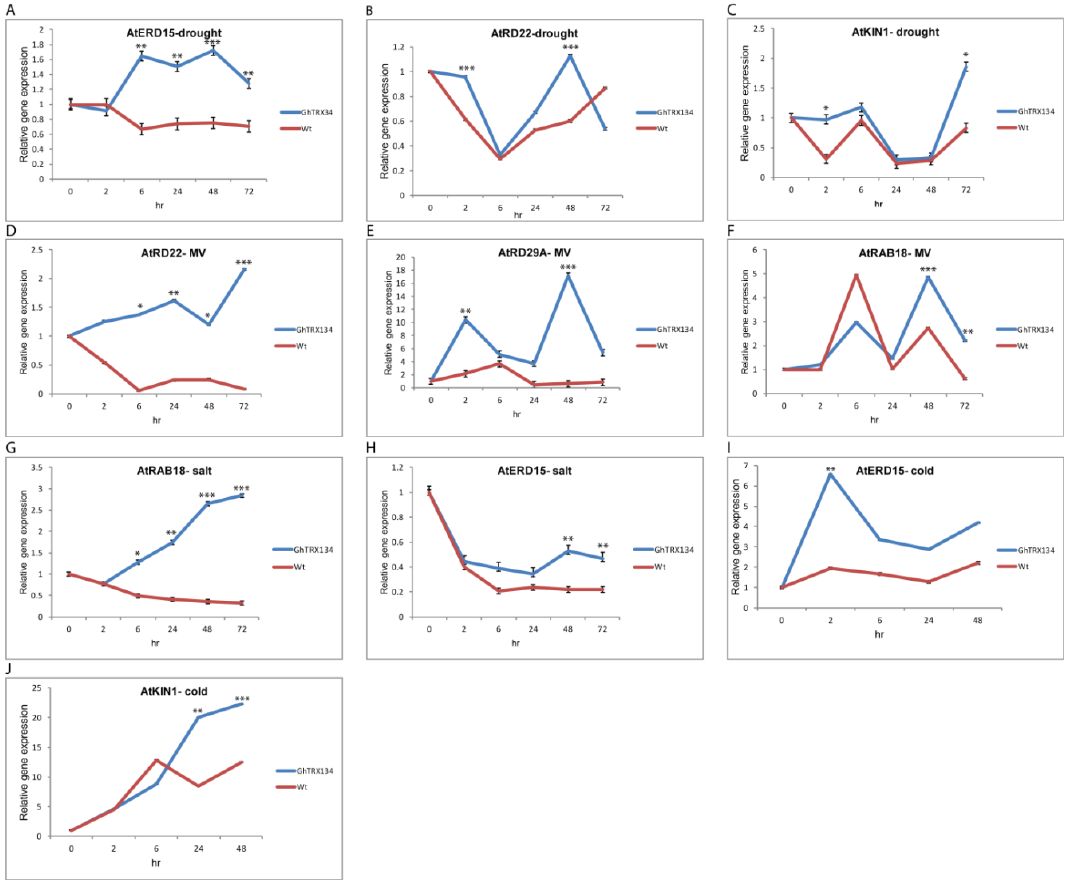
Figure 7. Expression of the AtERD15, AtRAB18, AtRD22, AtRD29A, and AtKIN1 responsive genes in two-week-old transgenic and Wt Arabidopsis plants under drought, MV, salt, and cold. ( A – C ) Drought 20% PEG. ( D – F ) MV 20 µ M. ( G , H ) Salt 200 mM NaCl. ( I , J ) Cold 4 °C for 72 h stresses was monitored